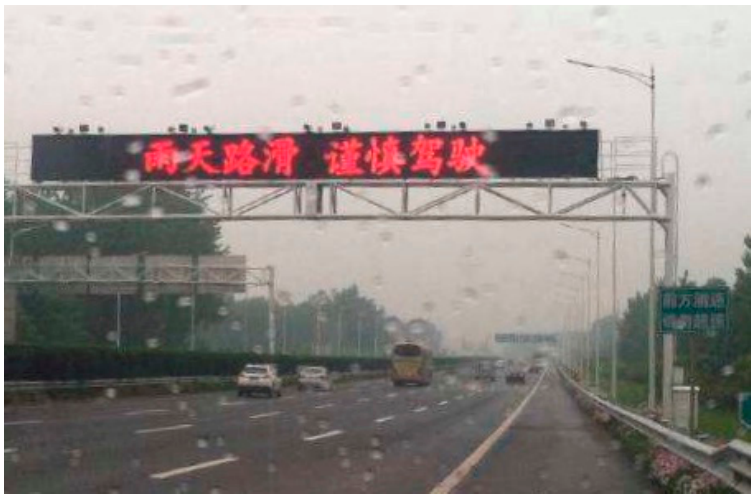
Figure 1. Variable message sign.